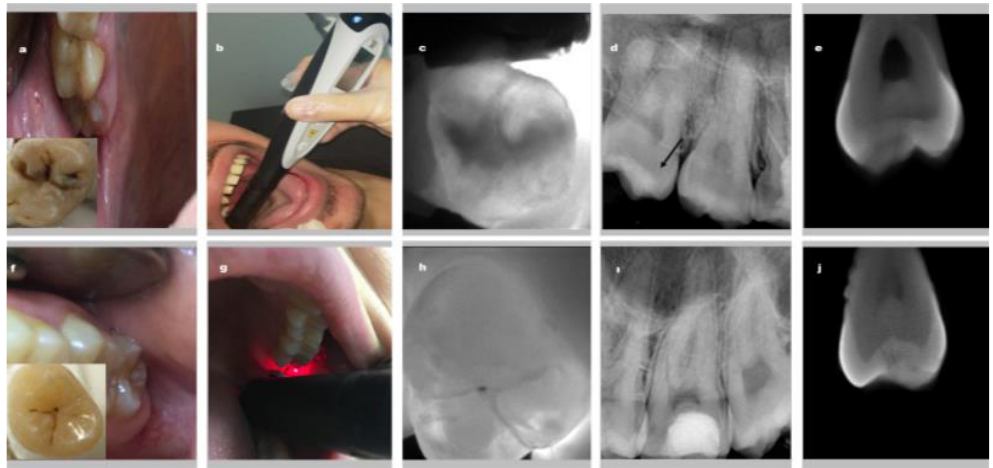
Figure 2. Representative images demonstrating all examination methods for dentin ( a – f ) and enamel ( f – j ) caries; ( a – f ) clinical visual examination, ( b – g ) laser fluorescence ( c – h ) near infrared light transillumination, ( d – i ) periapical radiography (the black arrow shows dentin caries in figure d), ( e – j )